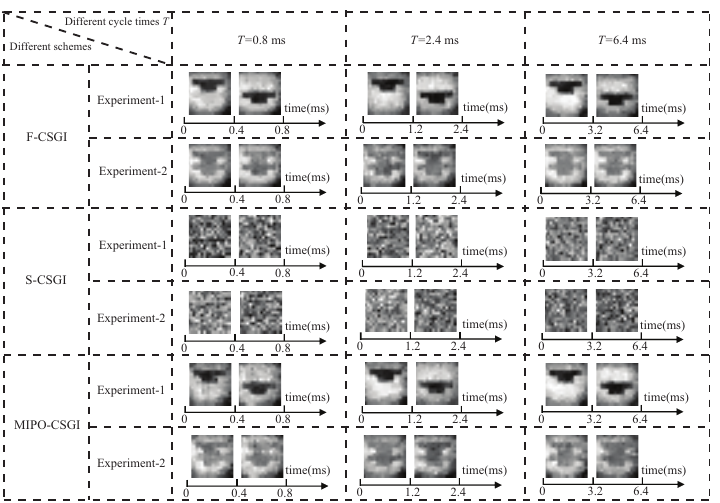
Figure 8. Experimental results of reconstructing two frames of the “ T ” under different cycle times T using F-CSGI, S-CSGI, and MIPO-CSGI.